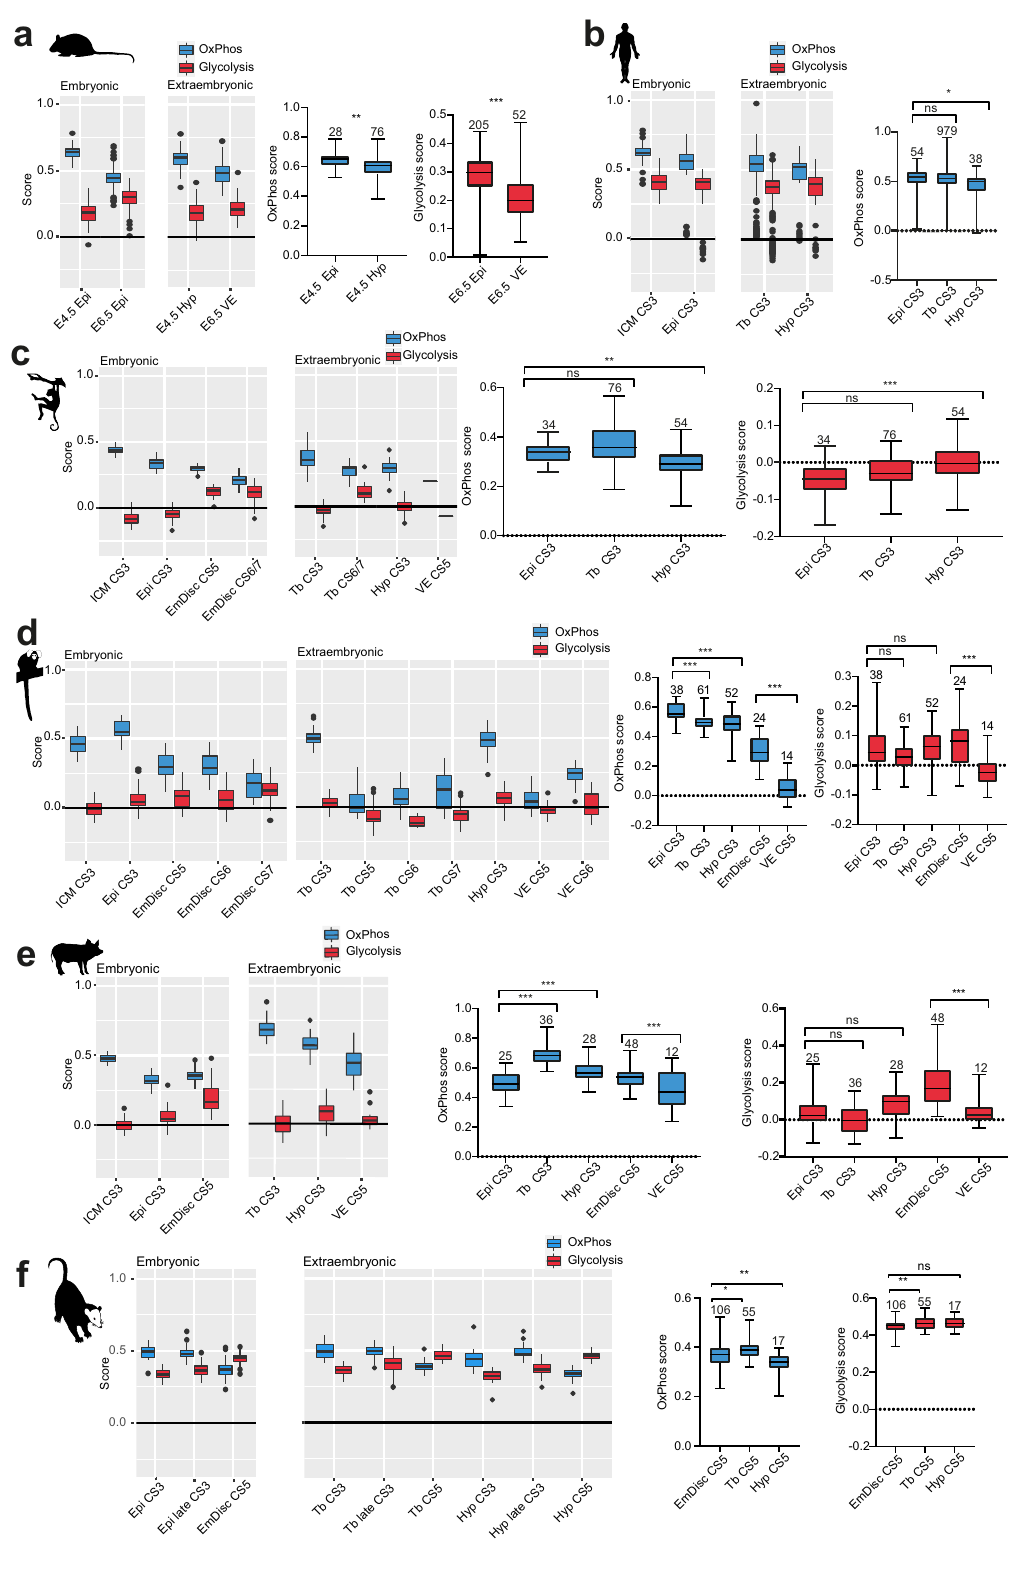
Fig. 5c). In the cynomolgus dataset, trophoblast did not tissues, however, OxPhos module scores were reduced in differ from epiblast in either OxPhos or glycolysis scores trophoblast and hypoblast, compared to epiblast (Fig. 3d). In (Fig. 3c). Marmoset late blastocysts glycolysis scores were not the post-implantation embryo, visceral endoderm exhibited signi fi cantly different between embryonic and extraembryonic substantially lower expression of OxPhos and glycolysis modules NATURE COMMUNICATIONS| (2022) 13:3407